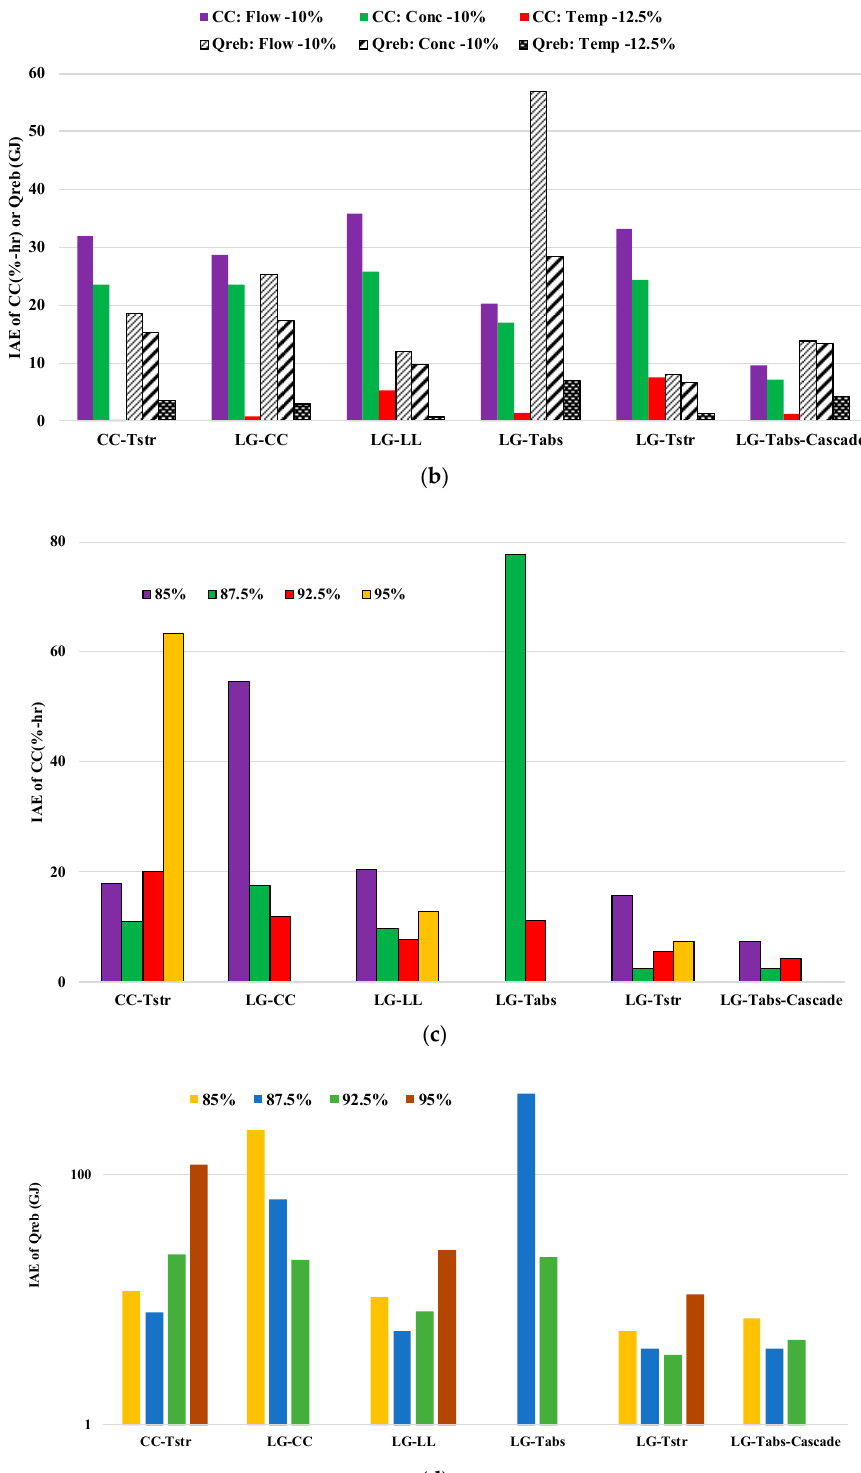
Figure 6. Integral of absolute errors (IAEs) of CO 2 capture e ffi ciency (CC) and reboiler heat duty (Q reb ) during the stabilization period for disturbance and set-point changes. A higher value of IAE indicates a greater extent deviation from the target capture e ffi ciency or a higher reboiler duty demand. ( a ) Increase of flue gas conditions; ( b ) decrease of flue gas conditions; ( c ) IAE of %CC for set-point change of CO 2 capture e ffi ciency; ( d ) IAE of Q reb for set-point change of CO 2 capture e ffi ciency (in logarithm